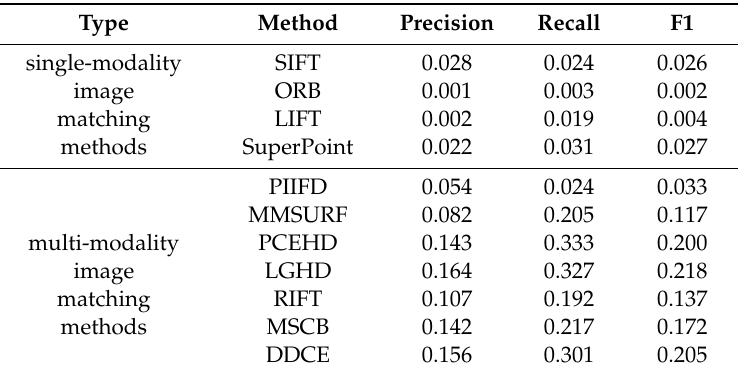
Table 7. Comparison of feature